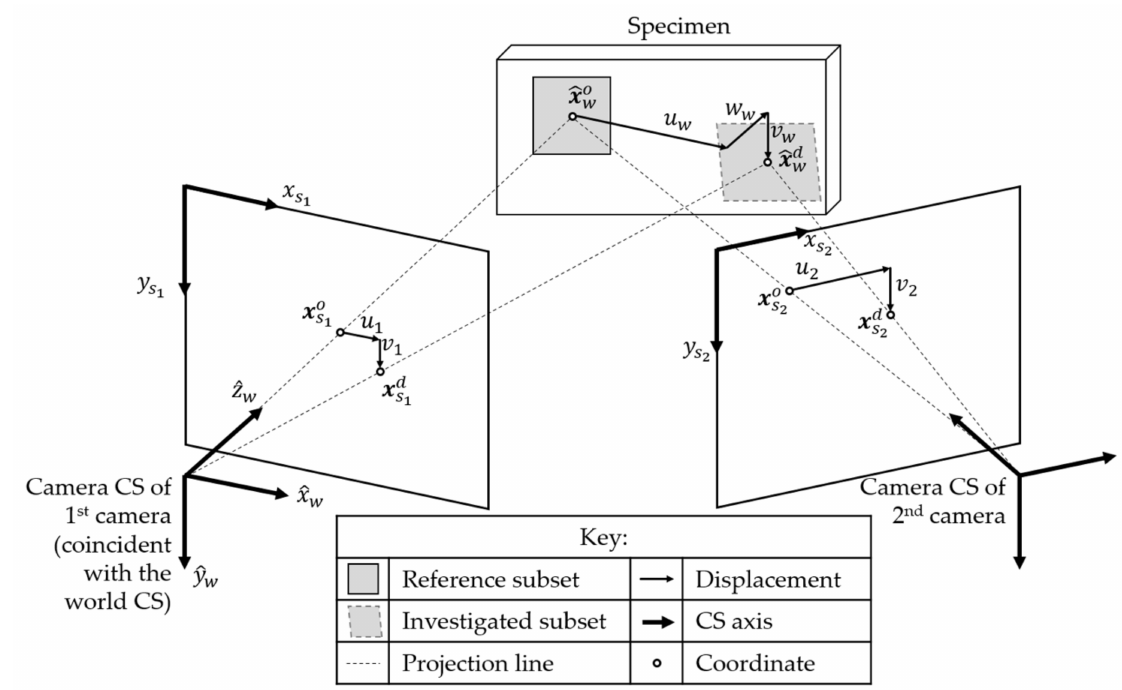
Figure 3. Schematic illustration of the displacement transformation process. Note that a projection line represents the combined process of distortion correction and